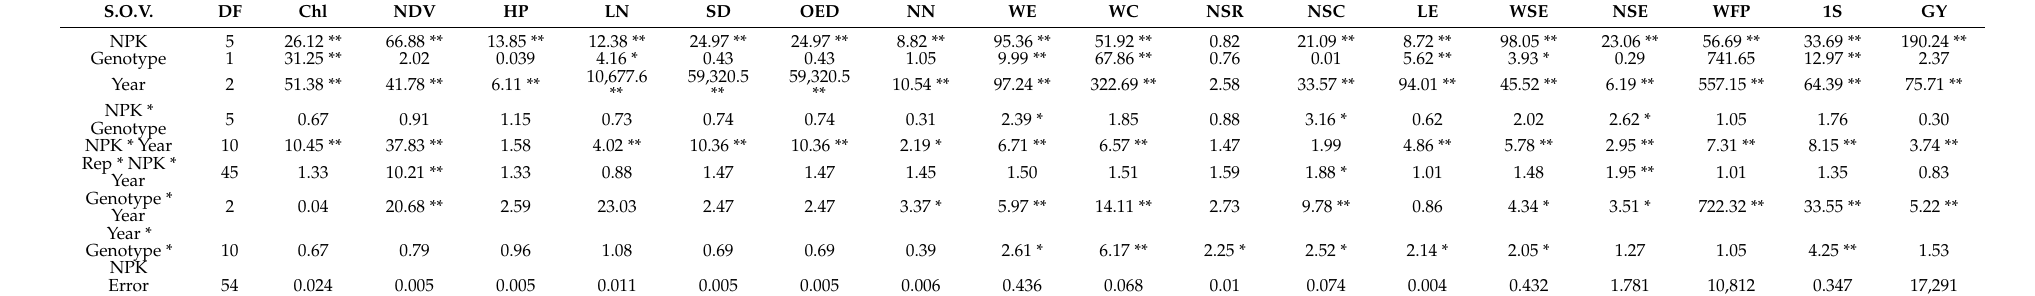
Table 1. Compound variance analysis on grain yield in FAO410 and FAO340 hybrids in six NPK